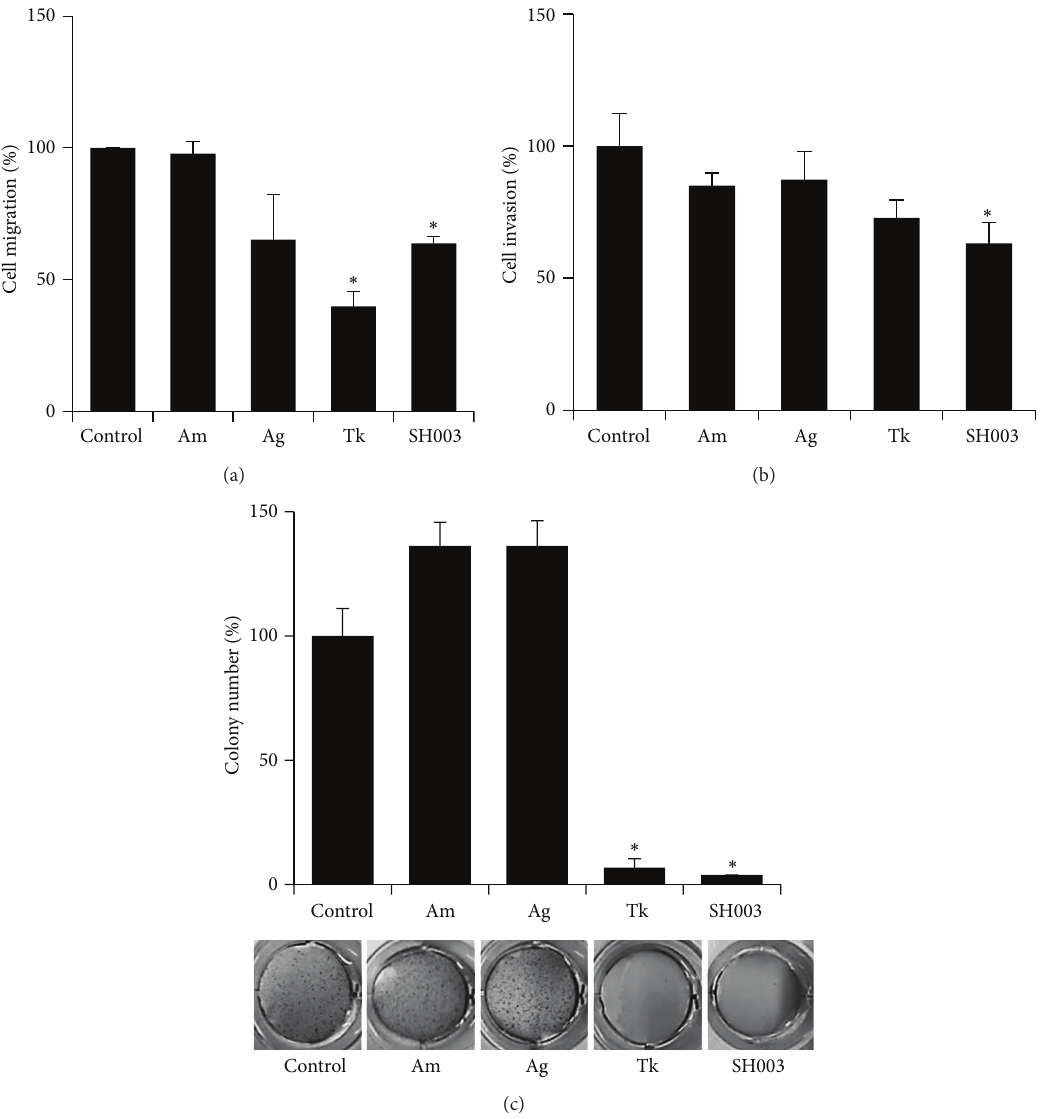
Figure 4: SH003 inhibits metastatic abilities in vitro . (a) MDA-MB-231 cells were scratched and treated with the indicatives for 24 hours. Cell migration was determined by counting cell numbers migrated from the wounding region. ∗ 𝑃 < 0.05 . (b) MDA-MB-231 cells were cultured on the upper chambers and treated with the indicatives for 24 hours. Invading cells were stained with crystal violet and then cell numbers were measured. ∗ 𝑃 < 0.05 . (c) MDA-MB-231 cells were cultured in soft agars and treated with the indicatives for 15 days. Colonies were then stained with crystal violet. ∗ 𝑃 < 0.05